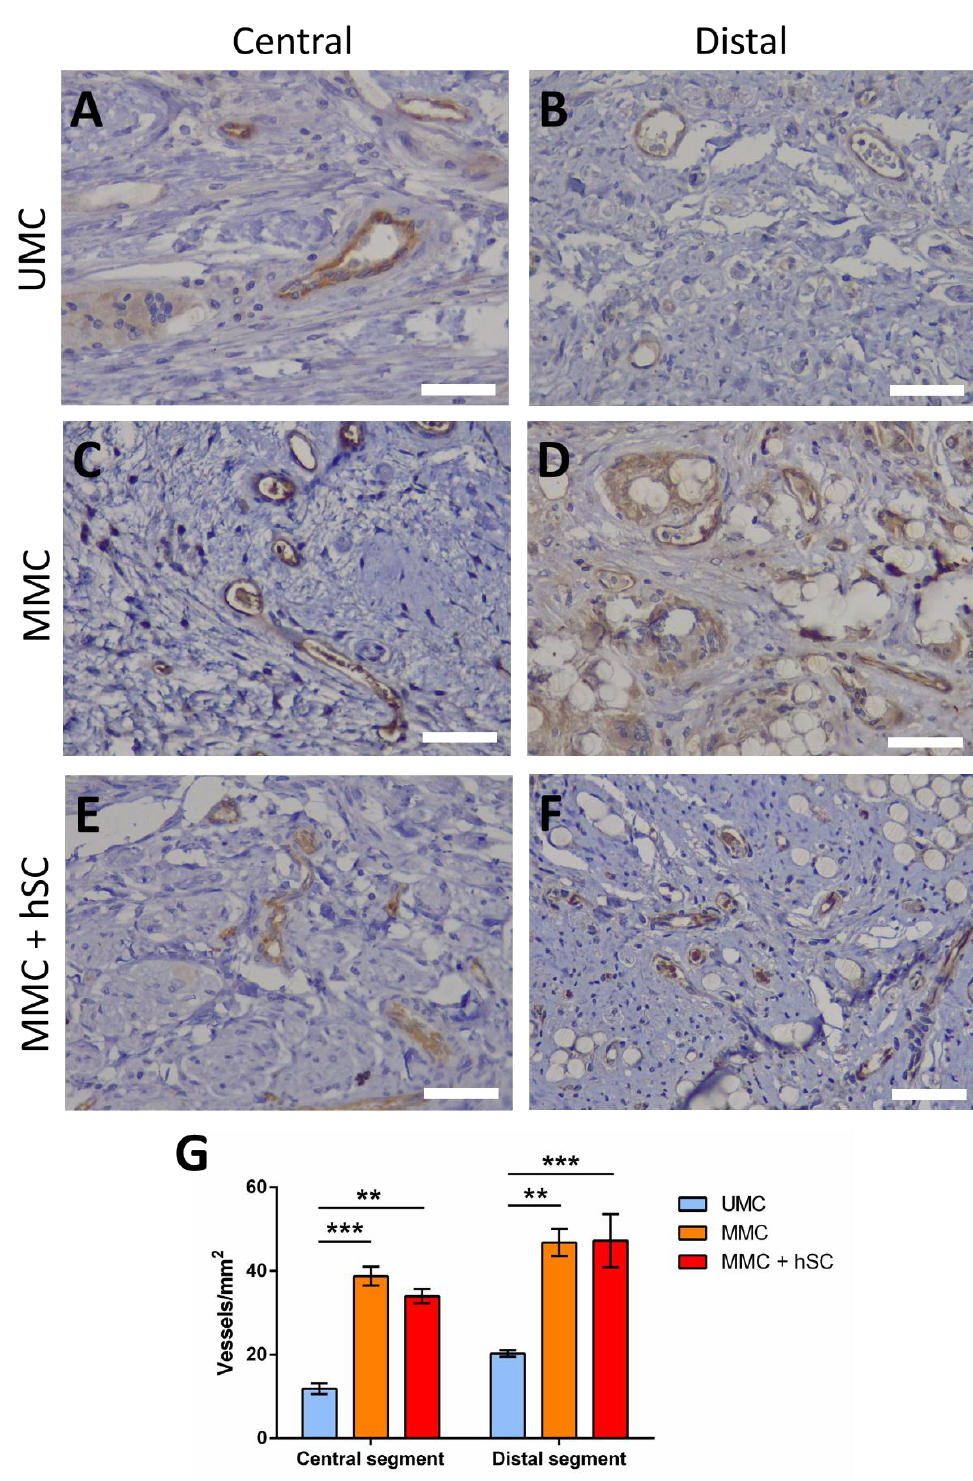
Figure 10. CD31 immunostaining images at central and distal portions and quantification of the number of vessels. ( A , B ) CD31 immunostaining of the UMC group at the central and distal portion, respectively. ( C , D ) CD31 immunostaining of the MMC group at the central and distal portion, respectively. ( E , F ) CD31 immunostaining of the MMC + hSC group at the central and distal portion, respectively. Blood vessels are marked with brown color. Scale bar = 50 µm. ( G ) Quantification of the number of vessels/mm 2 for the three groups at the central and distal portions. Statistically significant differences are indicated by ** or ***, indicating a p -value below 0.01 or 0.001, respectively.